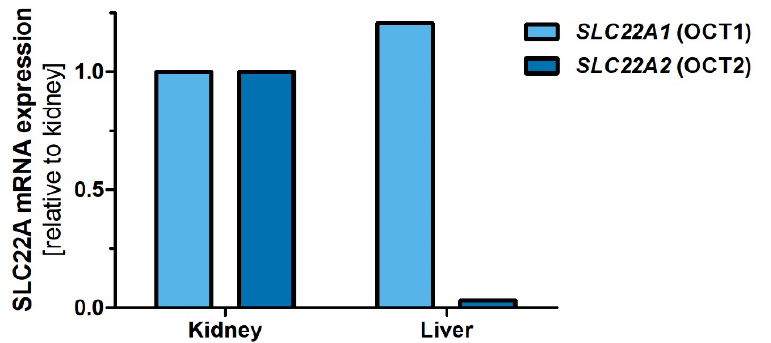
Figure 3. Organ expression of OCT1 and OCT2 mRNAs in dog liver and kidney. Expression of OCT1 (light blue) and OCT2 (dark blue) was measured in dog liver and kidney cDNAs using RT-qPCR. Expression was normalized to the expression of TBP and related to the expression in the kidney.